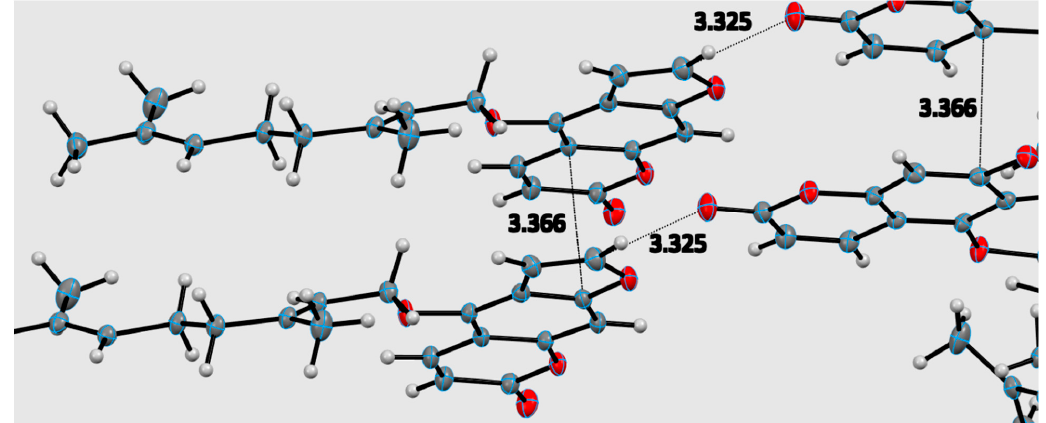
Figure 1. Labeling and bergamottin asymmetric unit in the crystal structure.